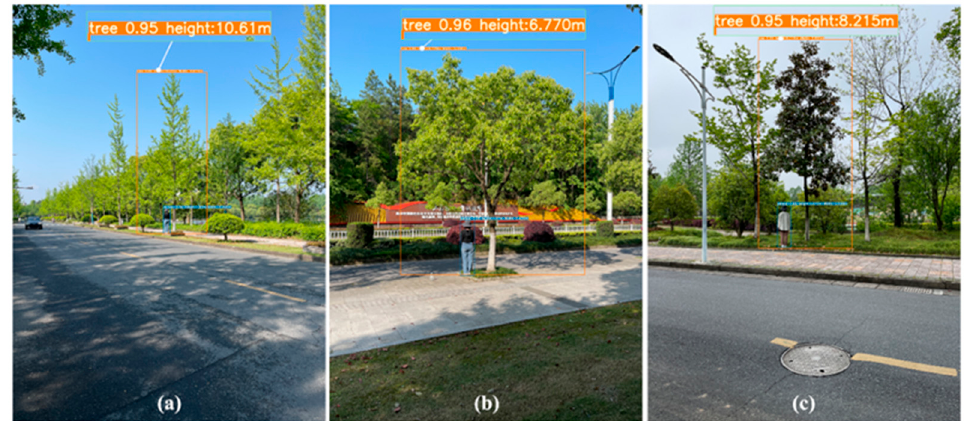
Figure 9. Examples of the person-tree scale height measurement model. ( a ) Measurement result of a GB. ( b ) Measurement result of a CC. ( c ) Measurement result of a YD. GB. ( b ) Measurement result of a CC. ( c ) Measurement result of a